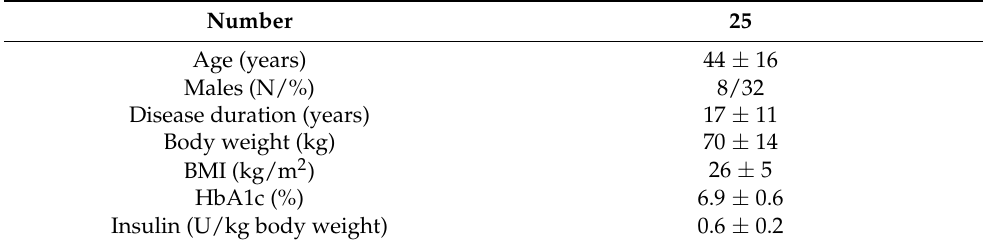
Table 4. Characteristics of study